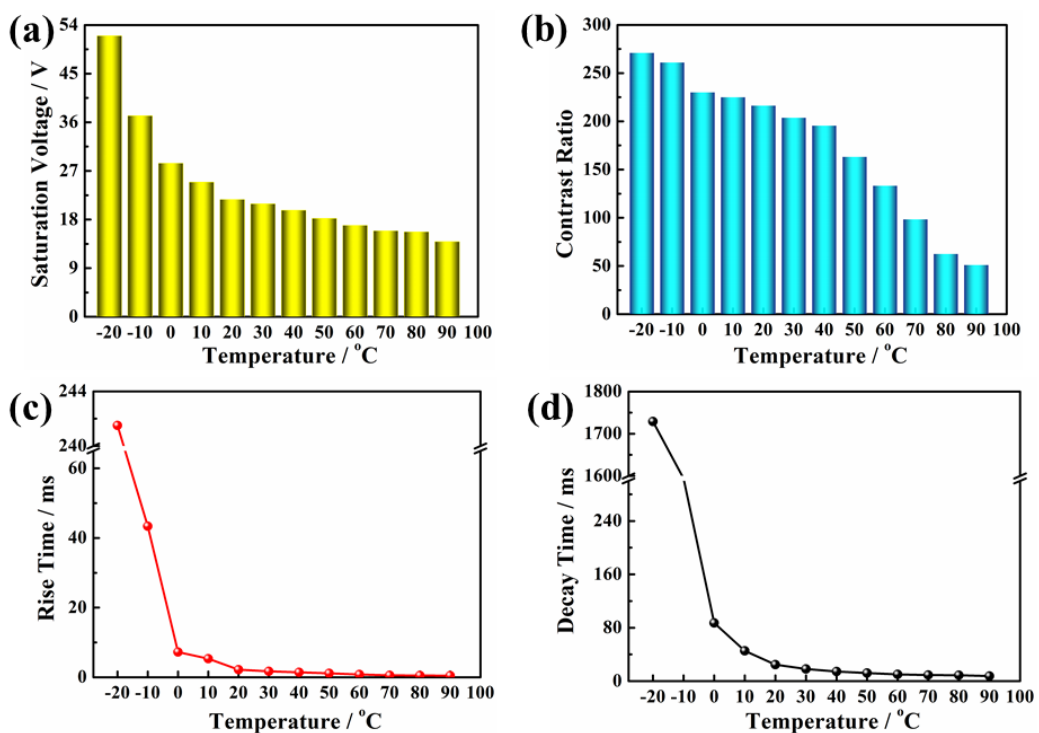
Figure 8. ( a ) The V sat , ( b ) CR , ( c ) t R and ( d ) t D of PDLC film at various temperature.